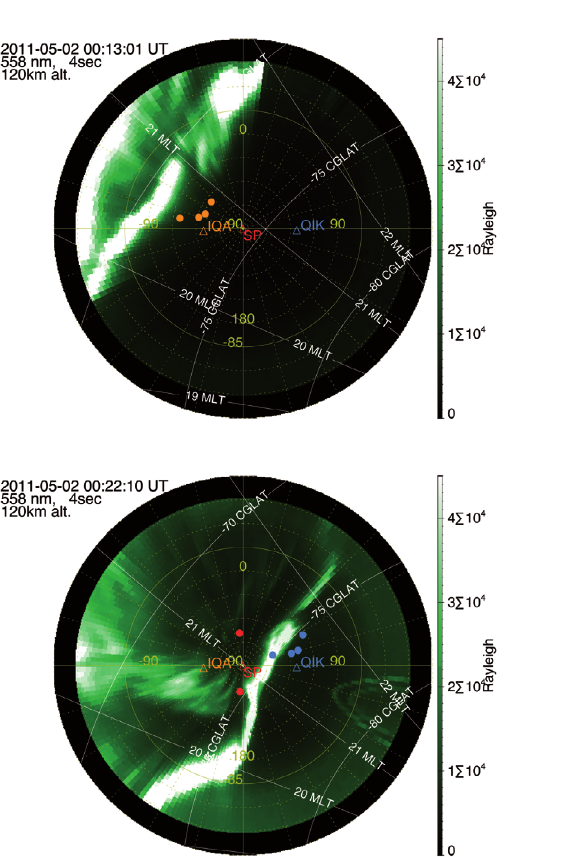
Figure 10. A sequence of mapped 557.7-nm images of a drifting arc in the pre-midnight sector on May 2, 2011.